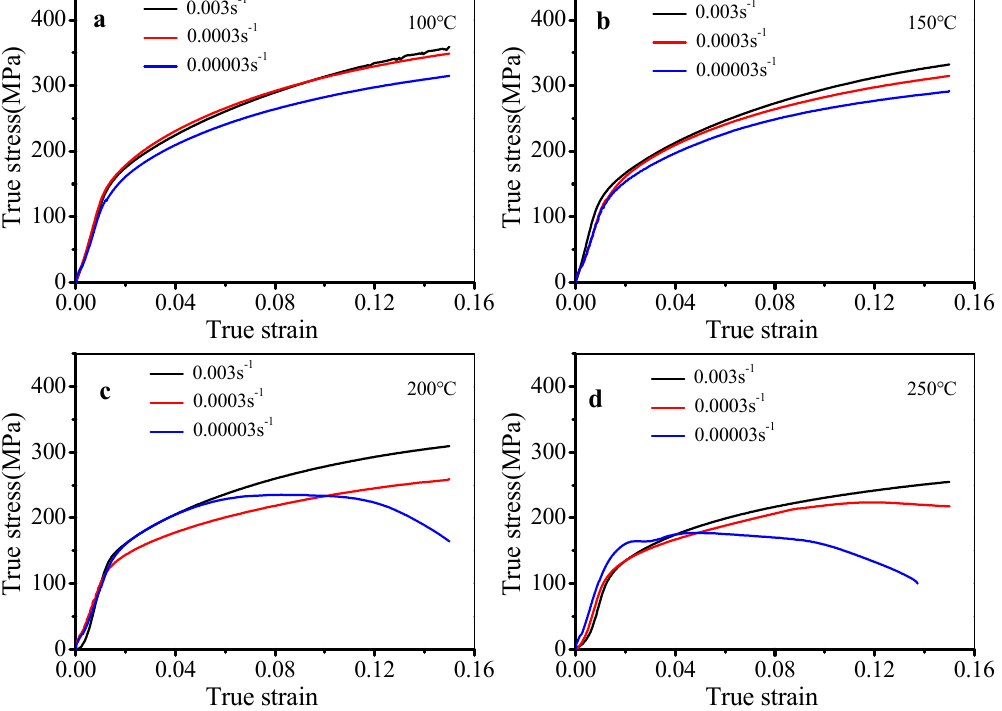
Figure 2. Flow stress curves at ( a ) 100 °C, ( b ) 150 °C, ( c ) 200 °C, and ( d ) 250 °C.